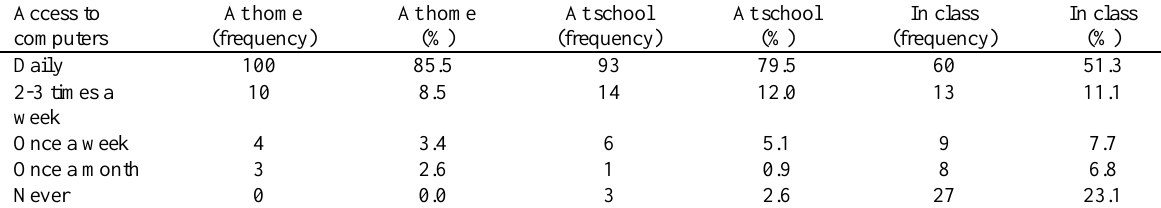
Table 3 Teachers' level of access to ET in various settings Access